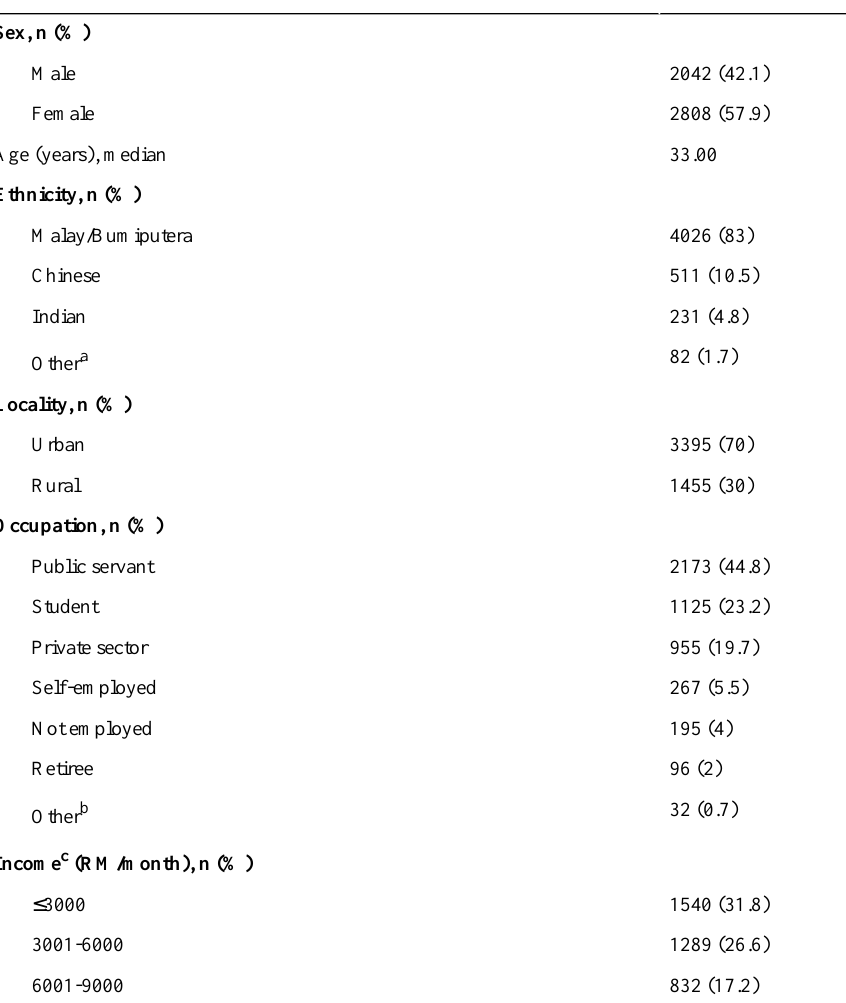
Table 1. Descriptive statistics for participant demographic characteristics and the sources participants used for obtaining COVID-19 information